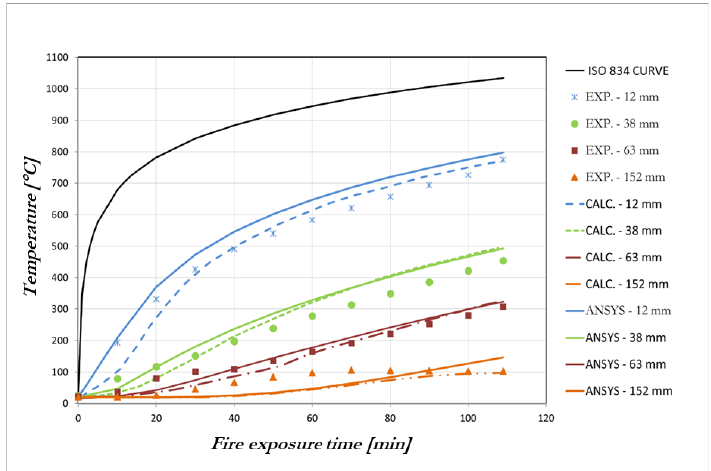
Figure 10. Comparison between experimental (EXP.), calculated (CALC.), and numerical values (ANSYS) of Column 3 temperature evolution at concrete points.